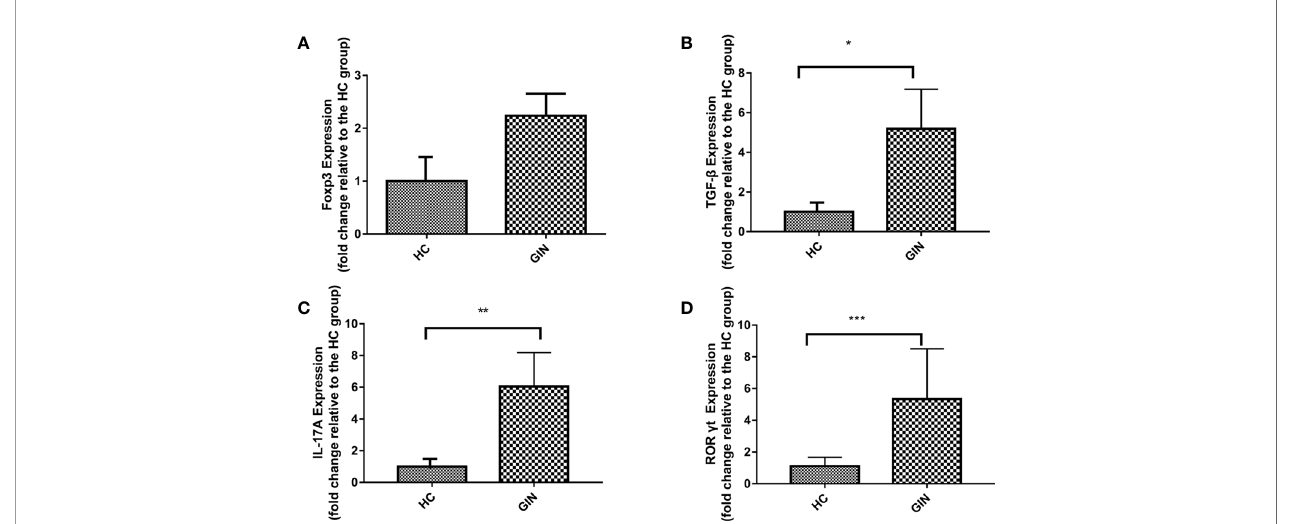
FIGURE 3 | Expression patterns of Foxp3, TGF- b , IL-17A, ROR g t in gingivitis patients and healthy controls. Data presented are means±SD. * P < 0.05, ** P < 0.01 versus healthy control. *** P < 0.001 versus healthy control. (A) Expression patterns of Foxp3 in gingivitis patients and healthy controls. (B) Expression patterns of